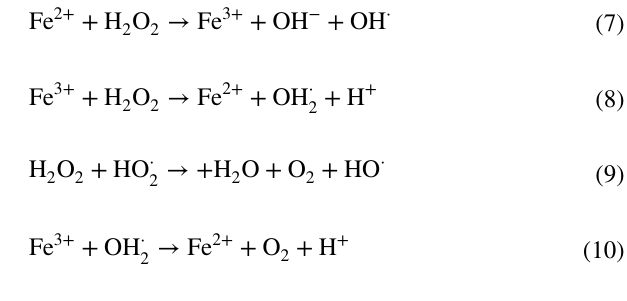
Table 3 ANOVA for Box–Behnken design model of BB9 dye oxida- tion*